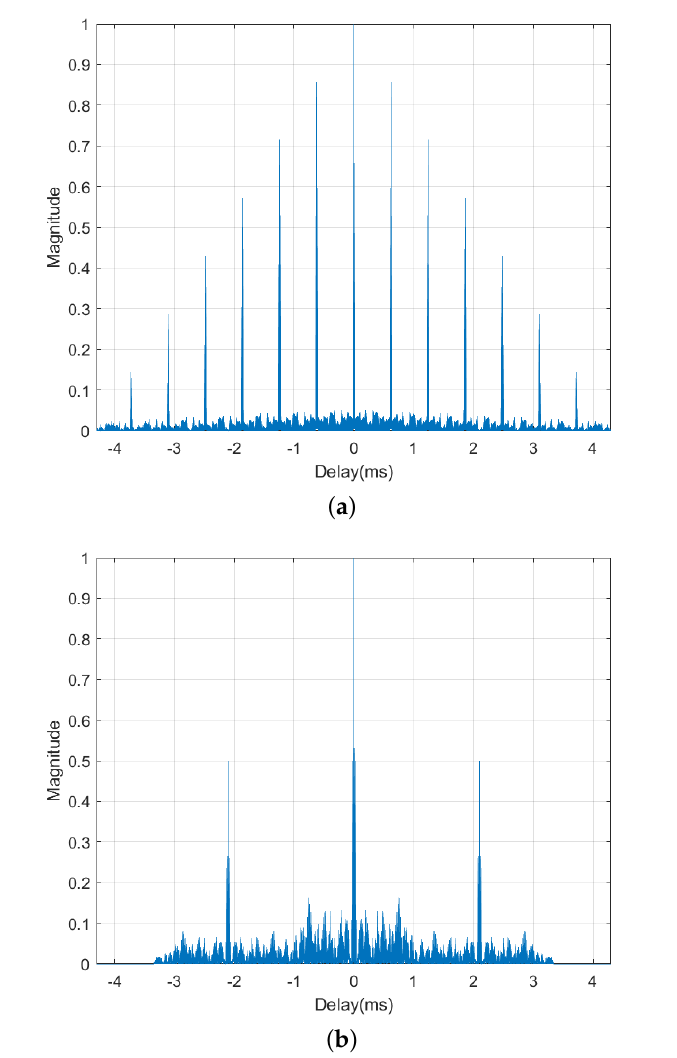
Figure 2. Autocorrelation functions of conventional signal and orthogonal combined signal: ( a ) autocorrelation function of conventional signal; and ( b ) autocorrelation function of proposed